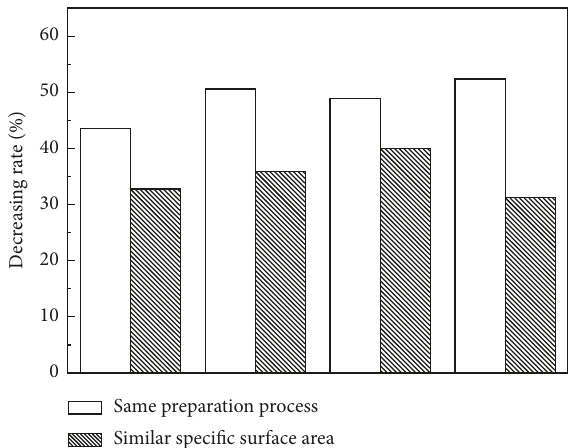
Figure 4: The decreasing rate in the strength of